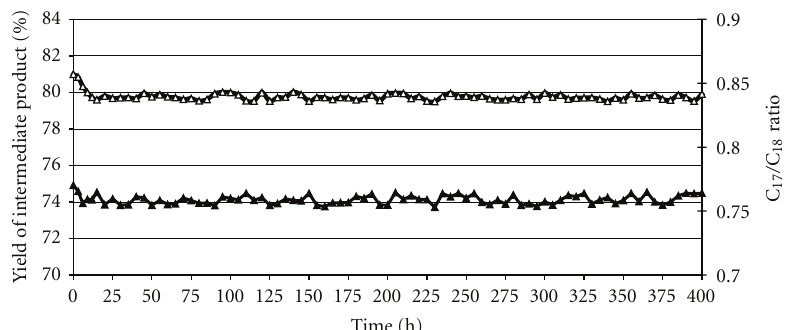
Figure 8: The change of the yield of the INPRP and the C 17 /C 18 ratio as a function of time; where: Δ -yield of intermediate product and -C 17 / C 18 ratio ( T = 360 ◦ C, P = 60bar, LHSV = 1.0h − 1 , H 2 /waste lard volume ratio = 600Nm 3 /m 3 ). (cid:3)